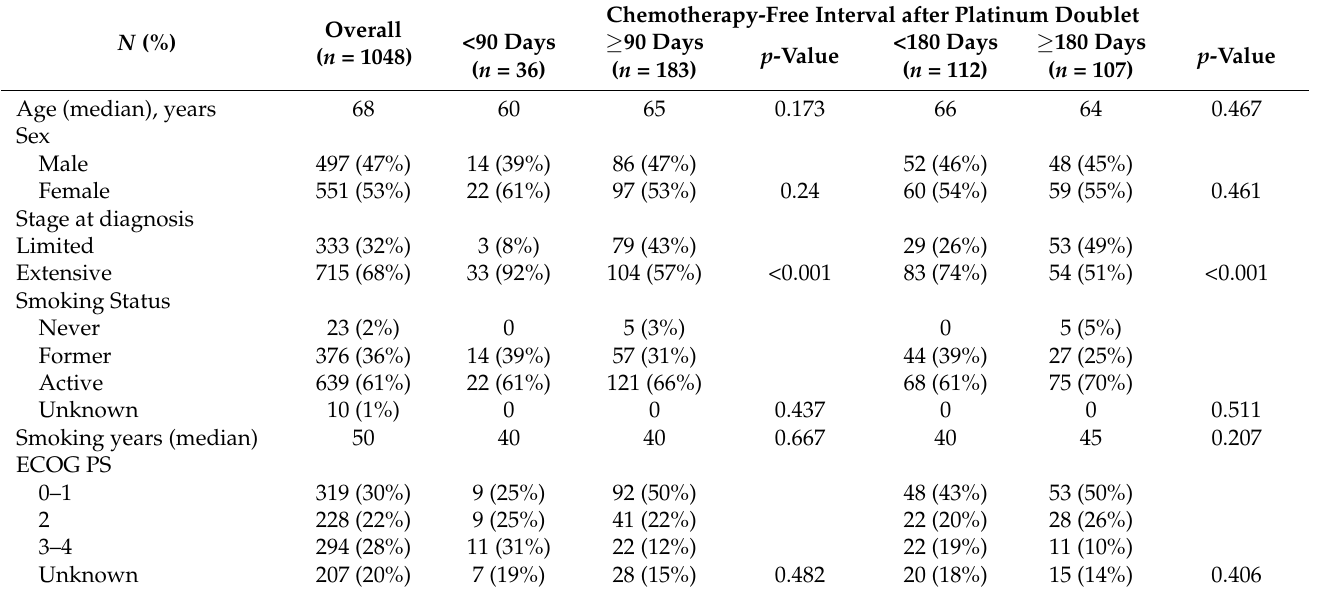
N = number; ECOG PS = Eastern Cooperative Oncology Group Performance